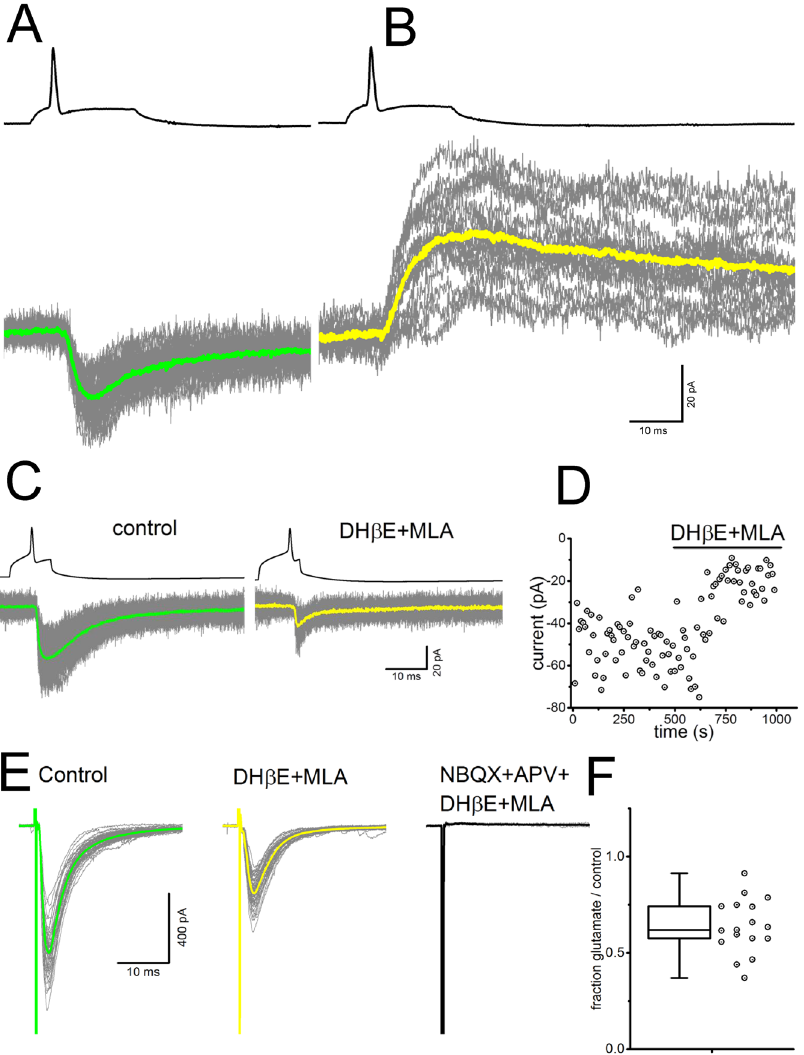
Figure 1. Glutamate and ACh co-transmission at young and adult MN-RC synapses. ( A–D ) Paired recording between a MN and a RC in slices from neonates (P5-P9). ( A ) In the presence of NBQX (2 µ M) the action potential (single trace, top, after offline bridge correction) elicited by a square pulse of depolarizing current (not shown) in the MN, elicits an EPSC in the RC, recorded in voltage-clamp at a holding voltage of − 60 mV, with a latency of 1.45 ms after the peak of the action potential. At negative potentials, most of the current is due to nicotinic receptors, since the NMDA component is affected by the Mg 2 + block at negative potential. ( B ) At positive holding potential ( + 30 mV), the nAChRs mediated currents are blocked by their rectification properties and a slow NMDARs mediated current is observed (yellow trace). ( C ) Pharmacological evidence of co-transmission in another pair of RC-MN recorded in a young pup (P8): amplitude of the EPSC in the RC before and after the application of the nicotinic antagonists MLA (10 nM) and DHßE (10 µ M). ( D ) Scatter plot of the time course of the amplitude of the EPSC in the RC before and during the application of the nicotinic antagonists. The RC is held at − 60 mV. ( E , F ) Pharmacological evidence of co-transmission in adults. ( E ) The synaptic current elicited in a RC by ventral root stimulation is shown before (left, green averaged sweep), and during the application of nicotinic antagonists (middle, yellow averaged sweep). Application of glutamate receptors antagonists (NBQX 3 µ M and D-APV 50 µ M) abolishes the remaining synaptic current. ( F ) Fraction of the synaptic current that can be ascribed to glutamate receptors (amplitude of the current in DHßE + MLA/ amplitude of the current in control conditions) in 17 RCs from adults